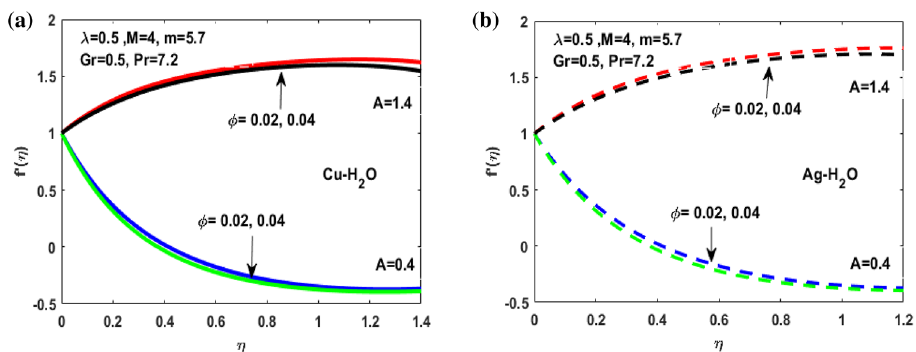
Figure 5. ( a ) Variation of (cid:31) for f ′ (η) . ( b ) Variation of (cid:31) on f ′ (η)